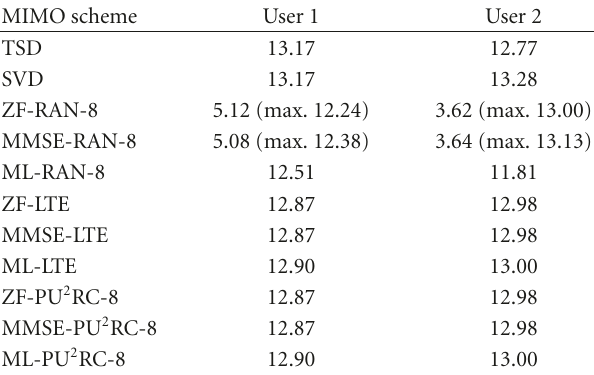
Table 1: Achieved rates for channel definition